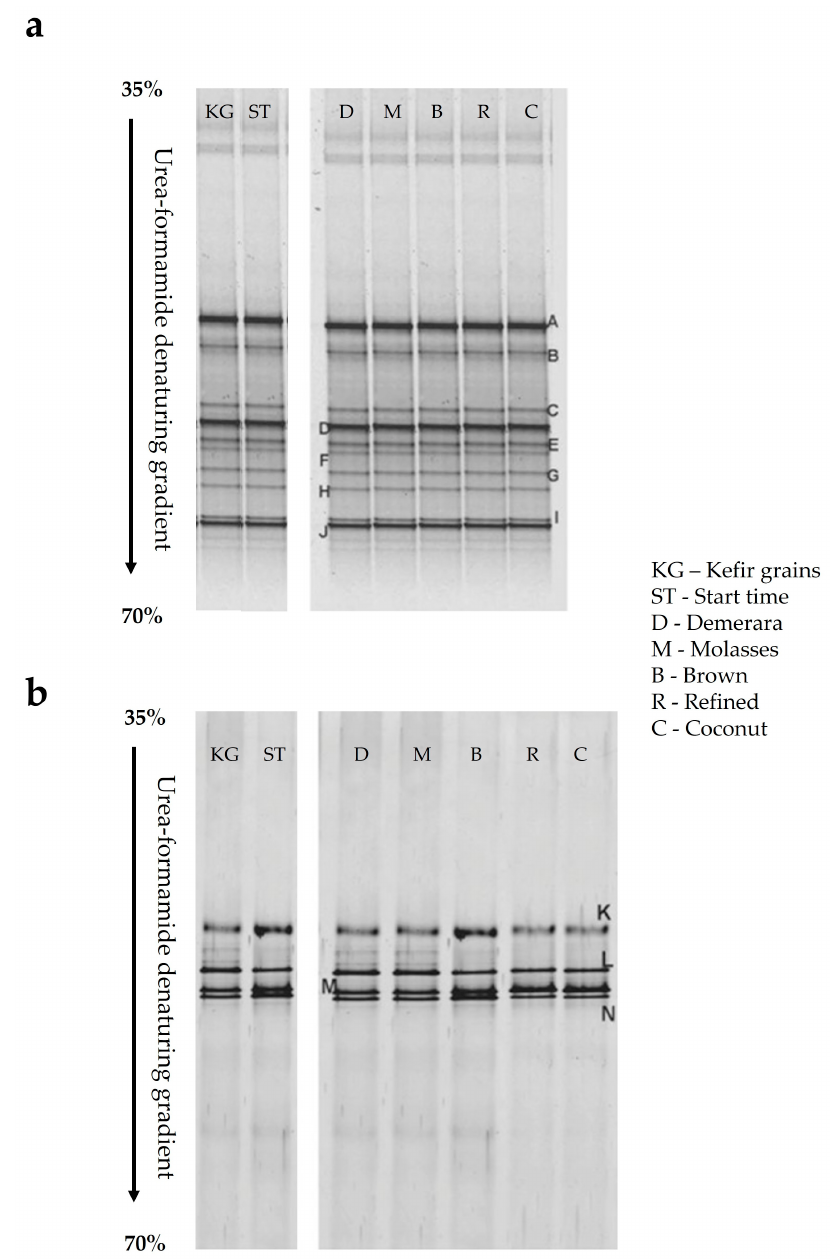
Figure 3. Profiles of microbial communities from water kefir grains and beverages. ( a ) Prokaryotic